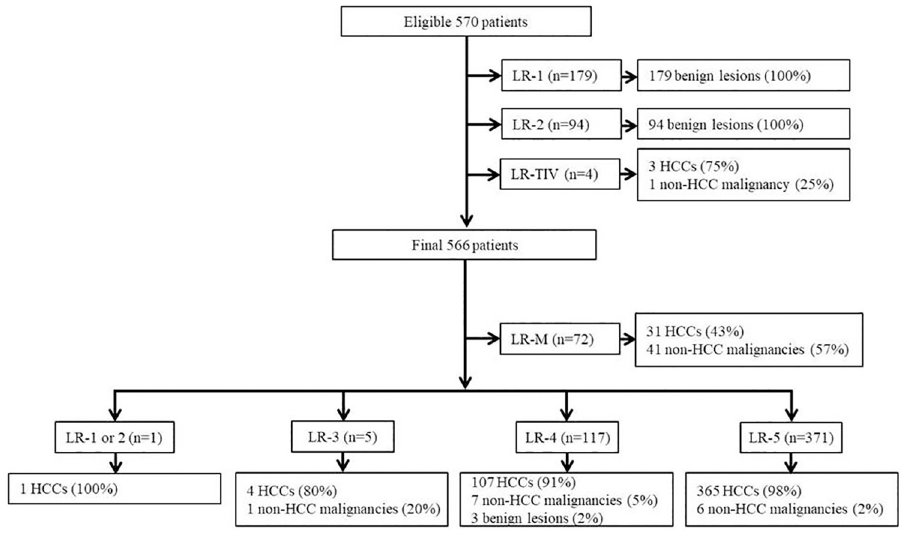
Fig 1. Study flow